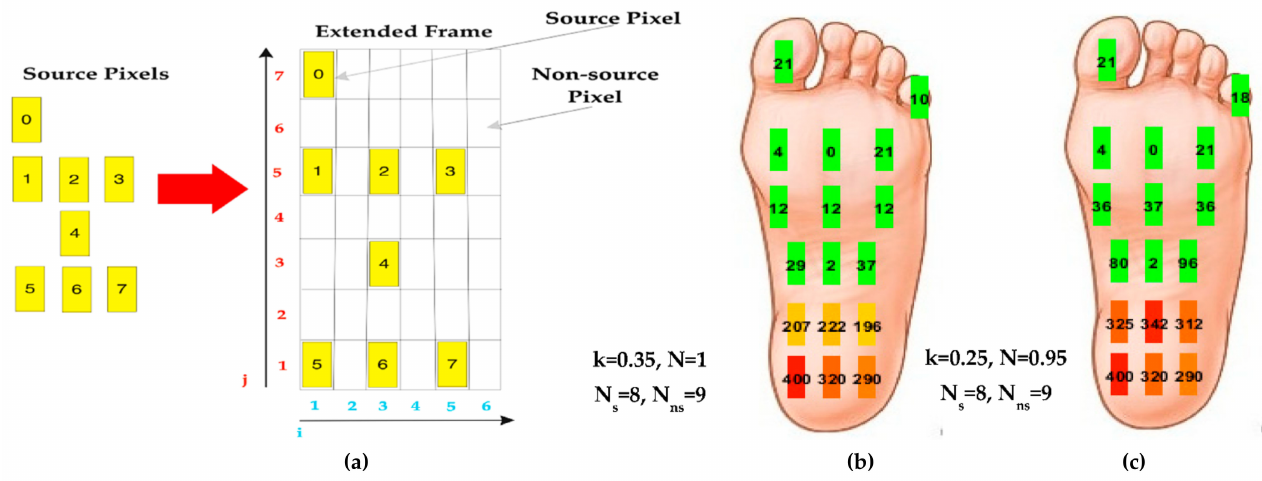
Figure 27. Extended pressure maps by applying the interpolation method proposed in [28] constituted by 17 pixels (N s = 8, N ns = 9 ( a ): the first one obtained with k = 0.35, N = 1 ( b ) and the latter with k = 0.25, N = 0.95 ( c